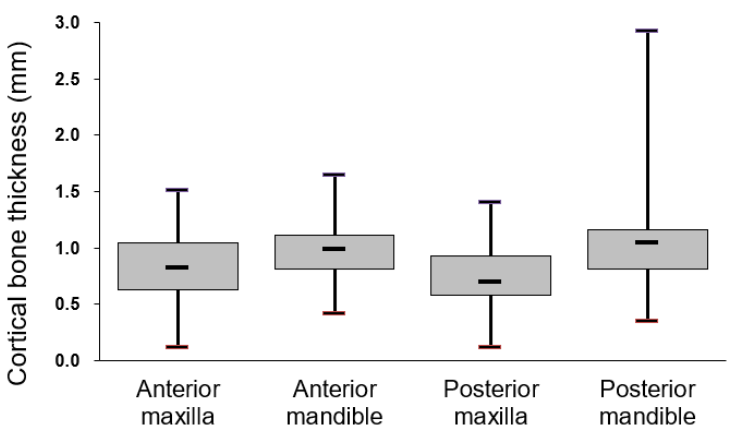
Figure 3. Cortical bone thickness at dental implant sites in different regions of the jawbone. Post-hoc Scheffe test results indicated significant differences ( p < 0.05) between the posterior mandible and the anterior maxilla, between the anterior mandible and the posterior maxilla, and between the posterior mandible and the posterior maxilla.